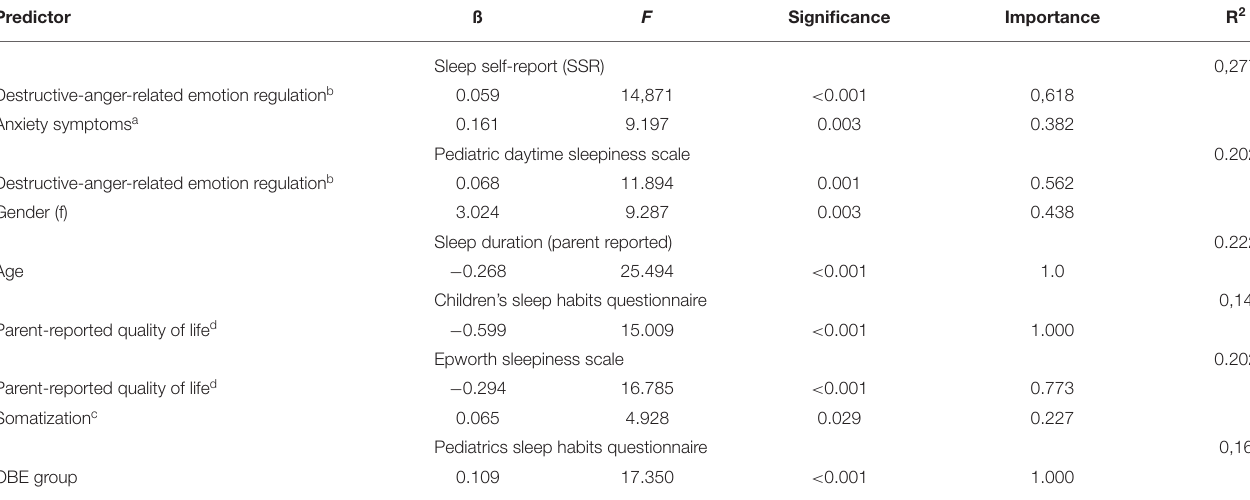
TABLE 5 | Summary of regression models.